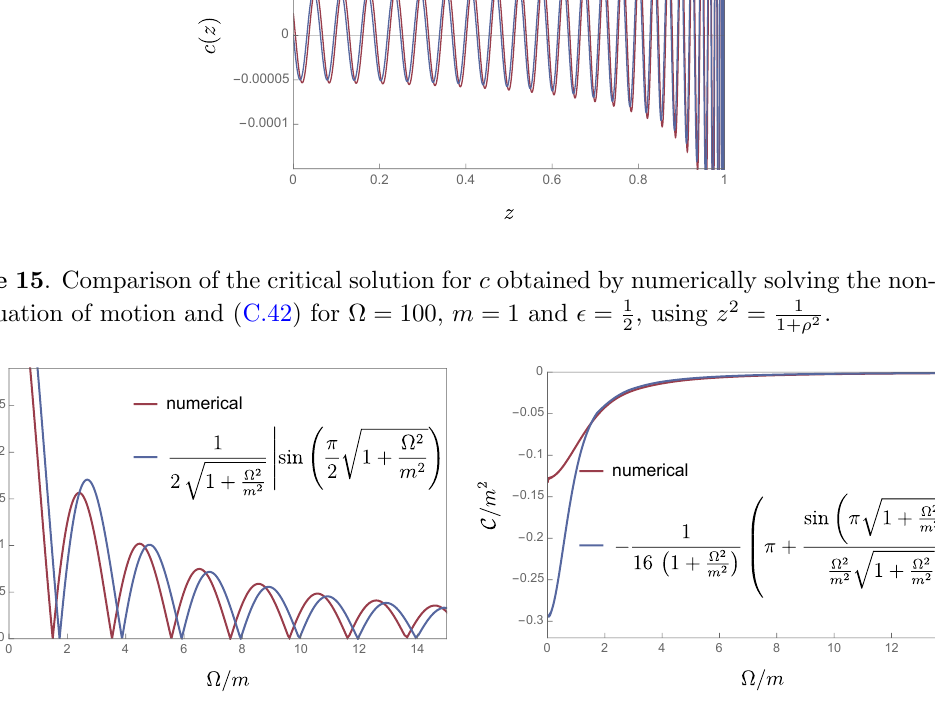
Figure 16 . E and C for critical solutions obtained numerically and using (C.43) with (cid:15) = 1 =